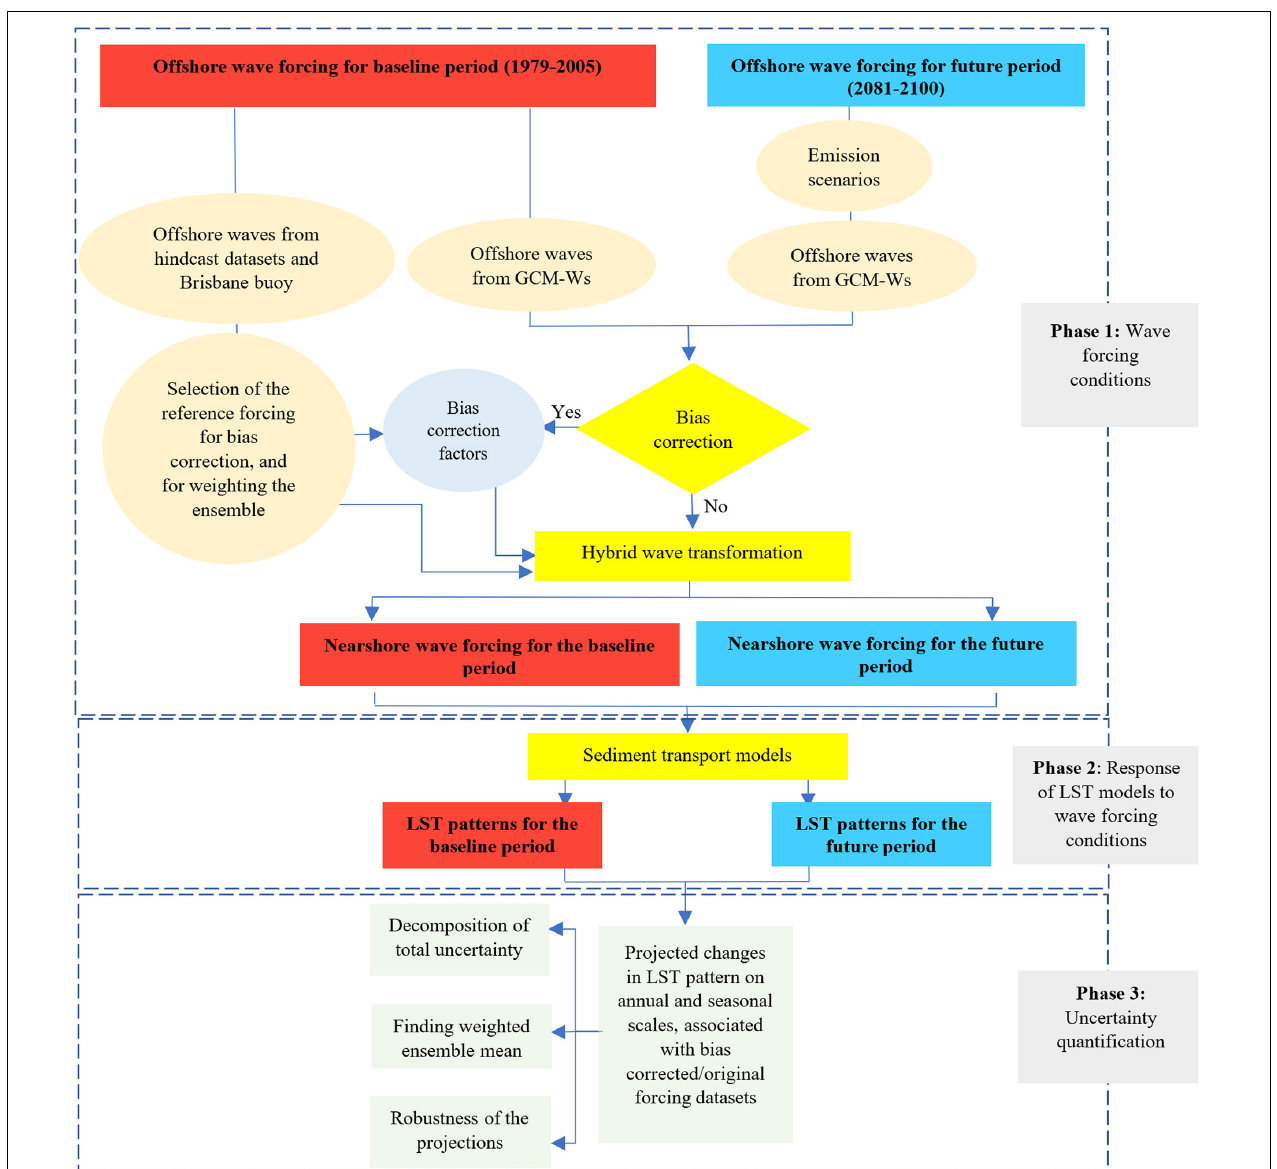
FIGURE 2 | Flow chart of the